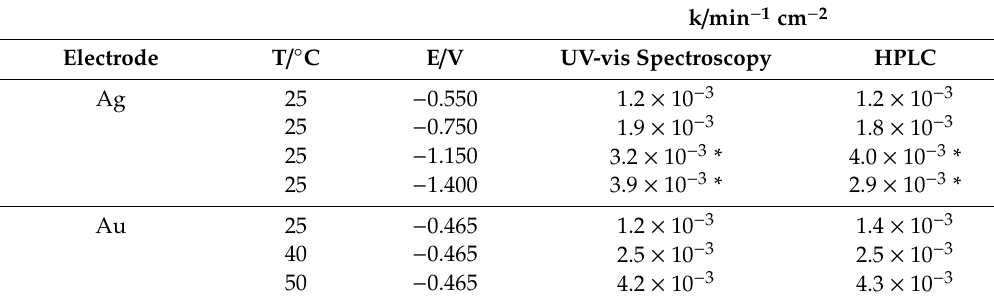
Table 1. Apparent kinetic constant for 4-nitrophenol